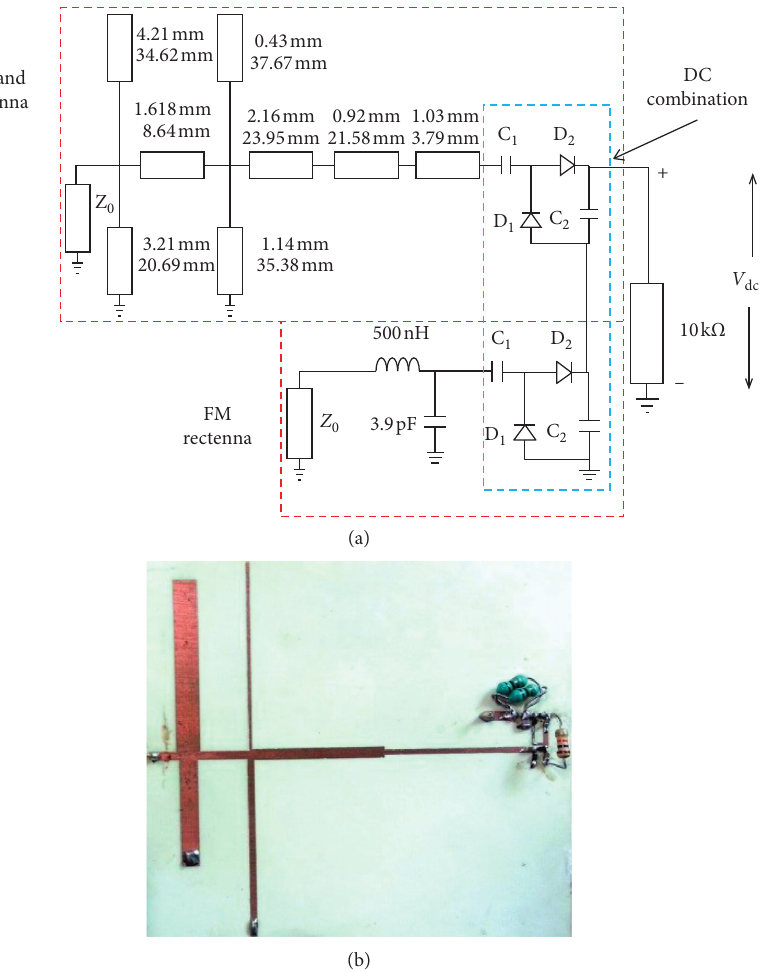
Figure 29: Proposed multiband rectifier. (a) Schematic. (b) Prototype (PCB size: 7 × 7 . 5cm 2 ).